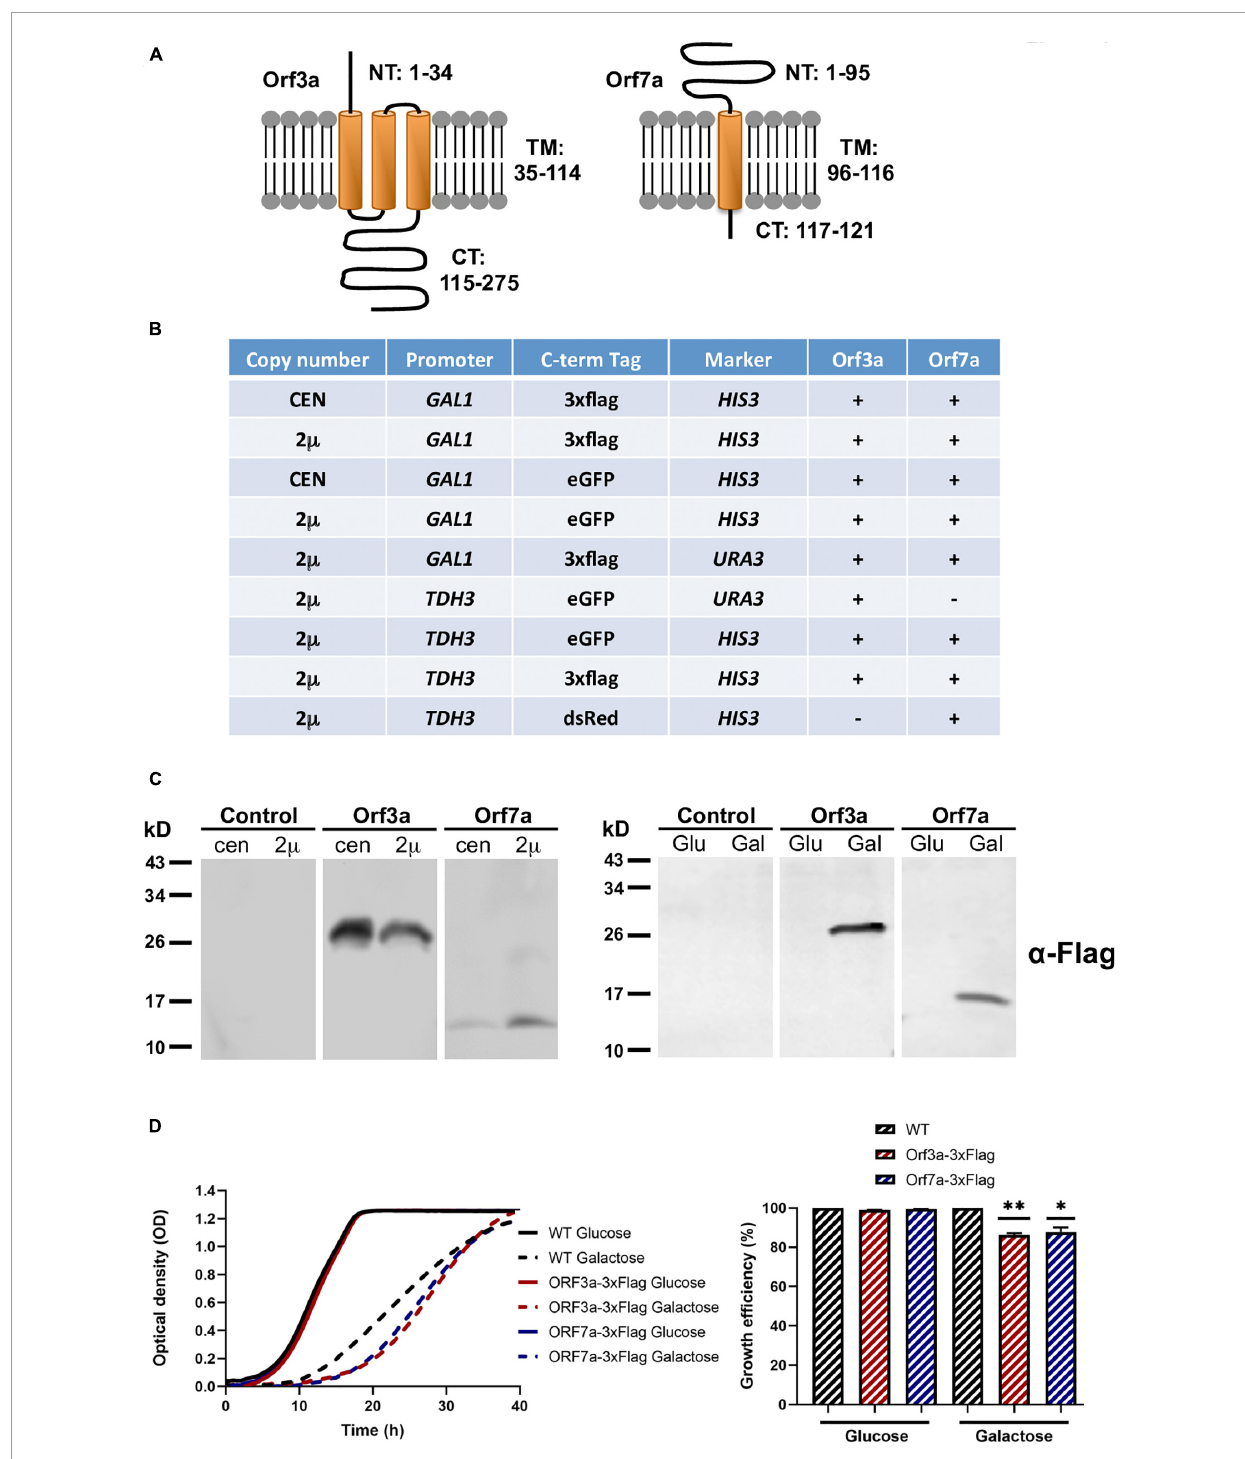
FIGURE1 Overexpression of the severe acute respiratory syndrome coronavirus-2 (SARS-CoV-2) small accessory proteins ORF3a and ORF7a in yeast. (A) Predicted topolgy of membrane inserted SARS-CoV-2 ORF3a and ORF7a. NT, N-terminal soluble domain; TM, trans membrane hydrophobic domain; CT, C-terminal soluble domain. Numbers indicate the amino acids comprising each predicted domain. (B) Heterologous yeast expression systems for the overexpression of differentially C-terminally tagged ORF3a and ORF7a proteins created in this work. CEN, centromeric plasmid; 2 µ , high copy plasmid; GAL1, galactose inducible GAL1 promoter; TDH3, constitutively active TDH3 promoter. (C) Immunological detection of constitutively (left panel) and galactose-induced (right panel) expression of SARS-CoV-2 ORF3a-flag and ORF7a-flag fusion proteins in yeast whole cell extracts. (D) Growth inhibition of SARS-CoV-2 ORF3a and ORF7a overexpression in yeast wild type cells. High copy, galactose-inducible expression plasmids were used. Left panel: Continuous growth curve determination; right panel: Representation of the relative growth efficiency. Growth of the empty plasmid control cells was set to 100% for glucose and galactose. Three independent biological samples were analyzed. Data are mean ± SD. ∗ p < 0.05; ∗∗ p < 0.01 (unpaired Student’s t